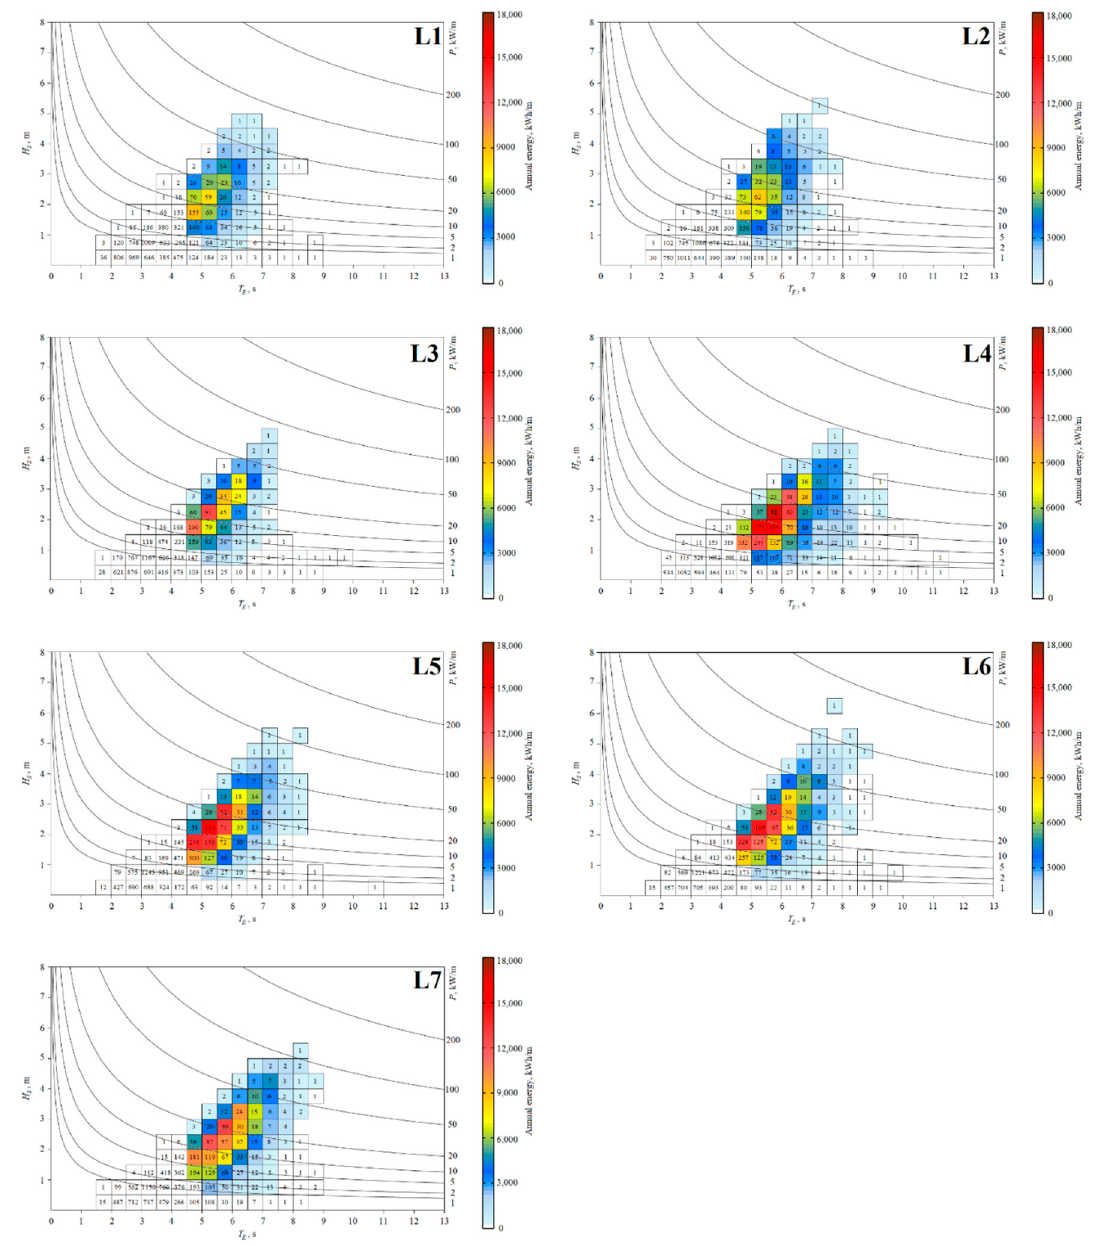
Figure 7. Characterisation of the annual wave energy at the investigated locations using the Pelamis. Table 4. Capacity factors.